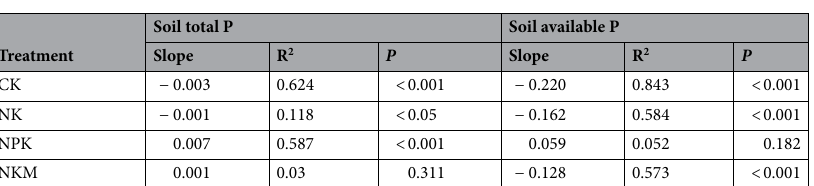
Table 1. Linear model analyzing the trend of soil total and available P content changing with experimental years (1981–2015). The slope is the average increase of soil total or available P content with year. R is the coefficient of the correlation between the soil total or available P content and the experimental year. CK: unfertilized control; NK: mineral fertilizer NK; NPK: mineral fertilizer NPK; NKM: mineral fertilizer NK combined with pig manure.